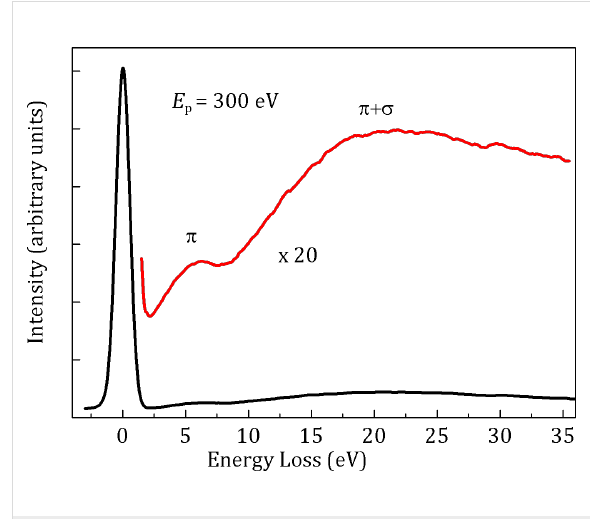
Figure 3: Electron energy loss spectra ( E p = 300 eV) obtained on the CNT-sponge. The π and π + σ plasmons have been emphasized for better view (red